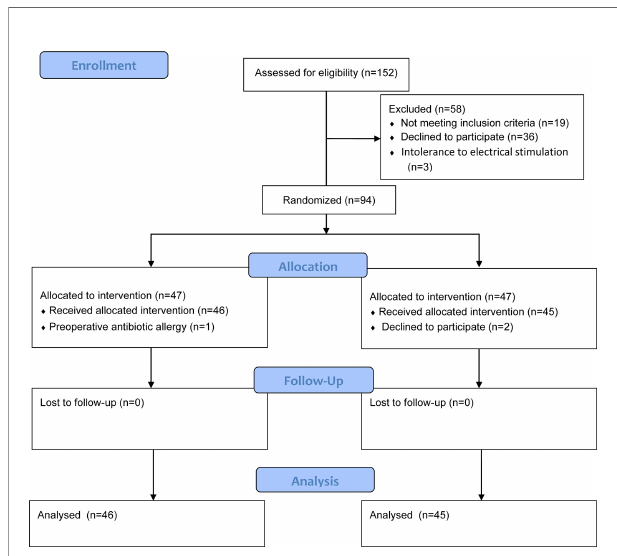
FIGURE 2 | Consolidated Standards of Reporting Trials (CONSORT) fl ow diagram.